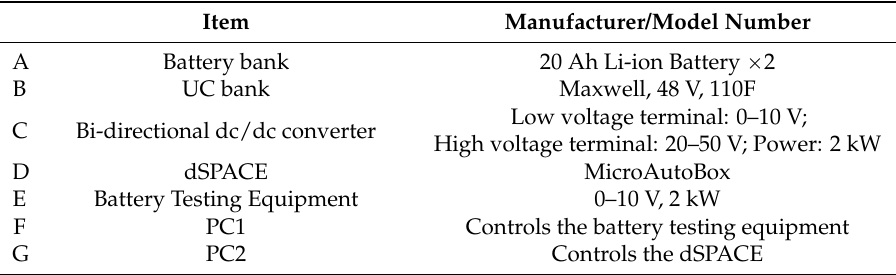
Figure 25. HESS test platform. Table 6. Equipment used in the test